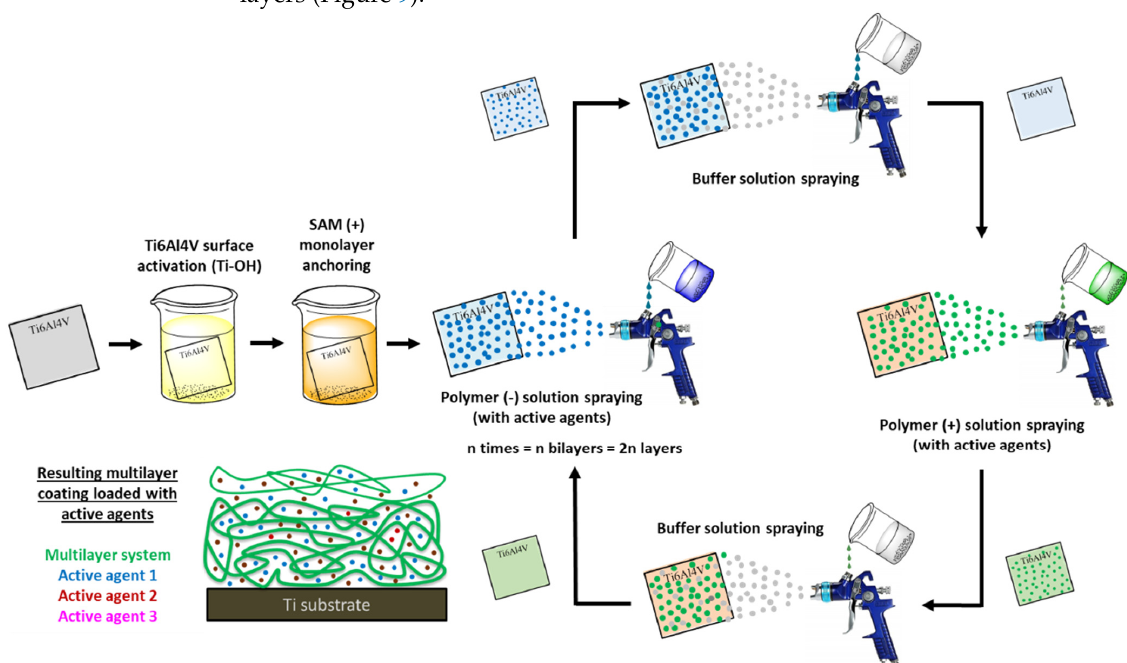
Figure 10. General schematic representation of LbL assembly by spray-coating method of positively- and negatively-charged polymers onto Ti6Al4V surface with loaded active agents.